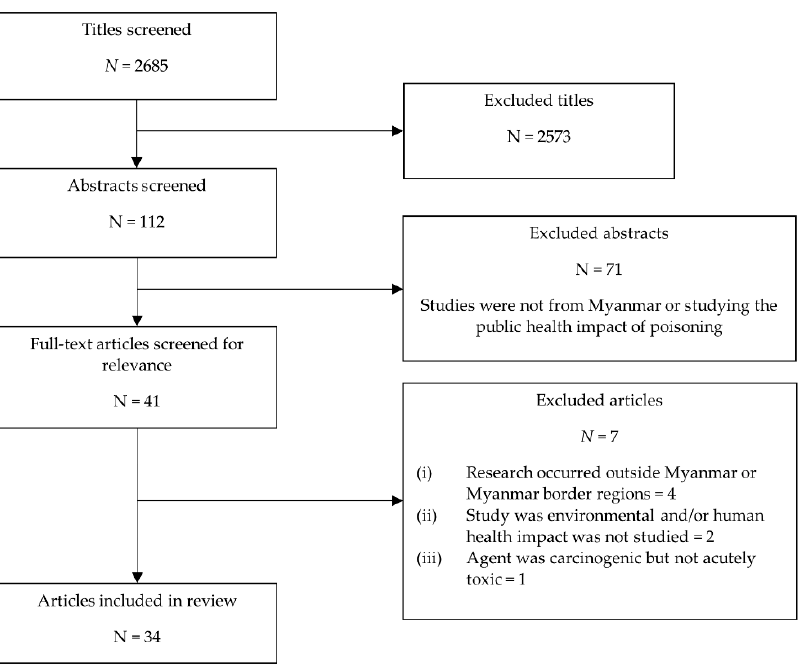
Figure 1. Flow chart showing inclusion and exclusion of articles.